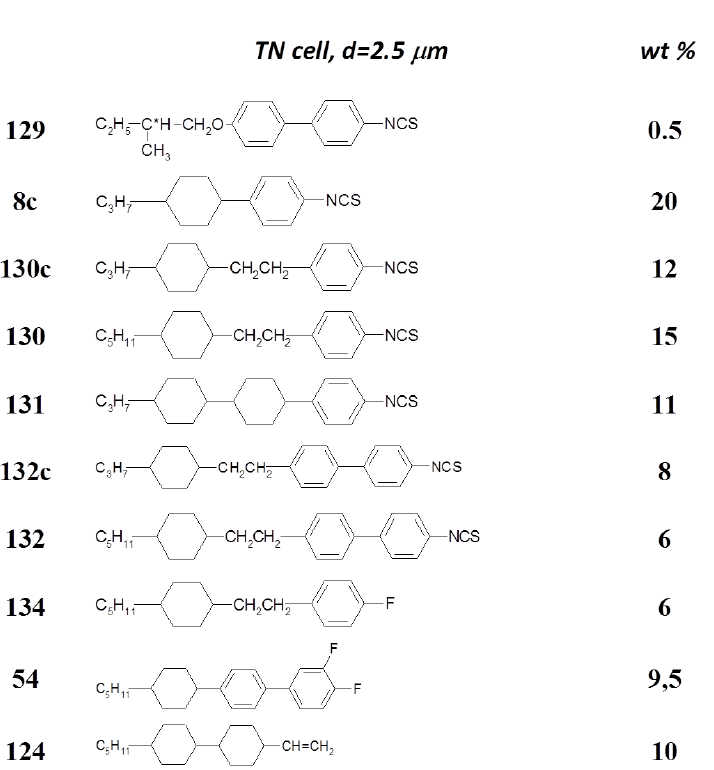
Figure 13. Medium birefringence low viscosity mixture 1892. The mixture properties: clearing point 88.6 °C,  n = 0.1891,  = 7.9, = 11.1 mPa·s, t V = 1.6 V, CR (diode) of 17.4 = th